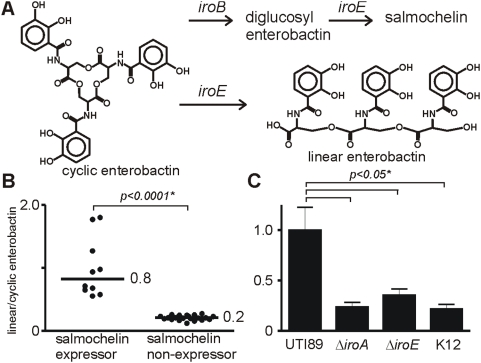
In addition to directing salmochelin biosynthesis, the iroA cluster also increases production of linear enterobactin, a candidate virulence-associated siderophore.A) Cyclic enterobactin is converted into a linear form by ester bond hydrolysis. B) Clinical isolates that produce salmochelin (+salmochelin) exhibit greater enterobactin linearization than salmochelin nonproducers (-salmochelin). C) Removal of the entire iroA cluster (iroBCDEN) significantly reduced enterobactin linearization. A similar reduction in enterobactin linearization is seen in an iroE mutant. Enterobactin linearization in MG1655, a K12 strain without the iroA cluster, was comparable to that seen in these mutants. These findings support the esterase IroE as an enterobactin linearizing enzyme in vivo.